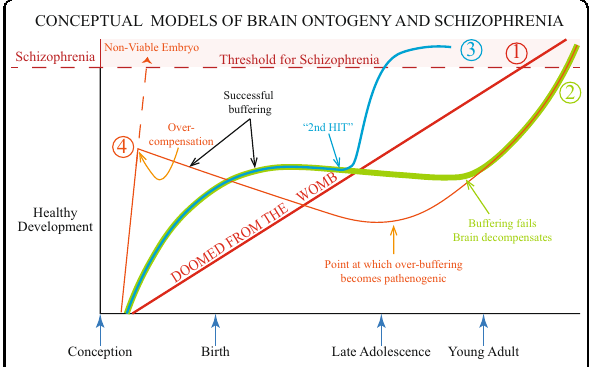
Fig. 1 Conceptual models of brain ontogeny and schizophrenia. Depicted are four scenarios regarding how abnormal brain development could be a causal factor in patients developing schizophrenia. The four options are described in detail in the text. Options 1 – 3 have all been outlined previously by others. Option 4 is highly speculative and based largely on observations on dopamine ontogeny in animal models of developmental risk factors for schizophrenia. Thereof course may be many other conceptual models for how abnormal brain development alters brain ontogeny contributing to